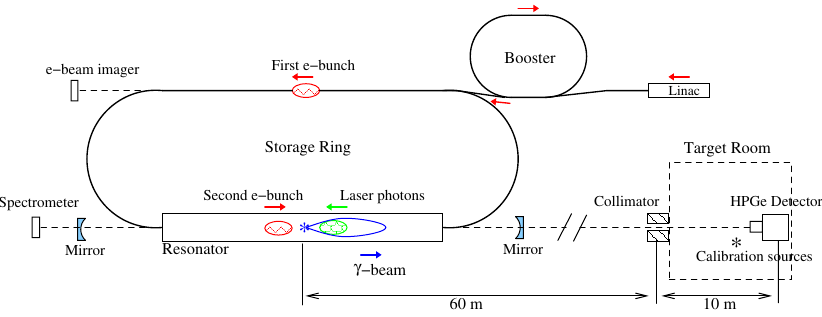
FIG. 7. (Color) Schematic of the HI (cid:1) S beam production and measurement at Duke